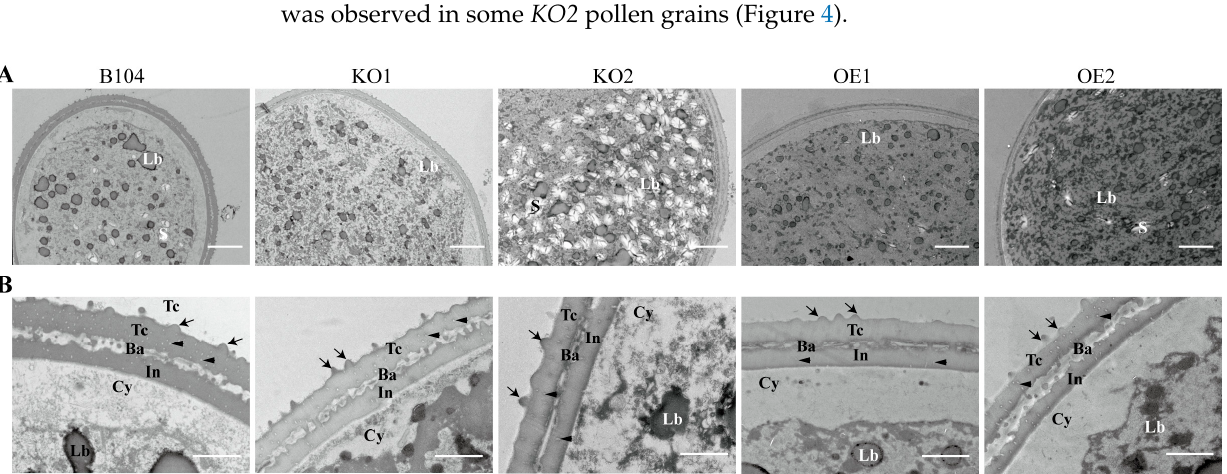
Figure 4. Representative TEM micrographs of pollen grains from WT and transgenic plants. ( A ) a pollen grain. Scale bar: 5 µm; ( B ) part of a pollen wall. Scale bar: 1 µm. TC: tectum; Ba: Bacula; In: Intine; Cy: Cytoplasm; S: Starch granules; Lb: Lipid body. Arrowheads indicate speckles present in the tectum, whereas arrows indicate the surface attachment of pollen exine.